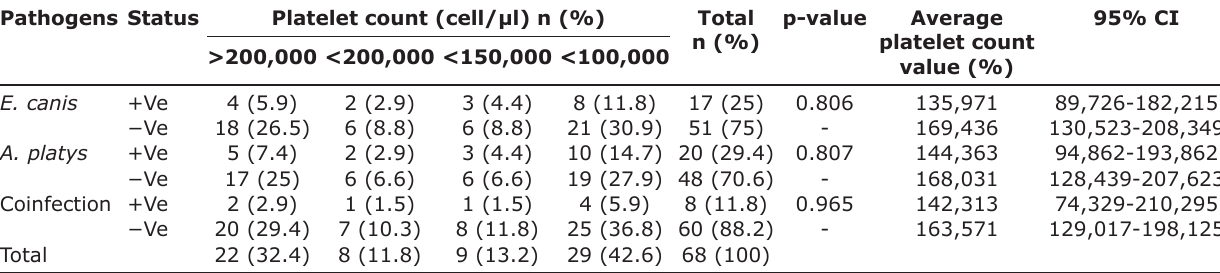
Table-3: Association among E. canis, A. platys , and coinfections with platelet count. Pathogens Status Platelet count (cell/µl) n (%) Total